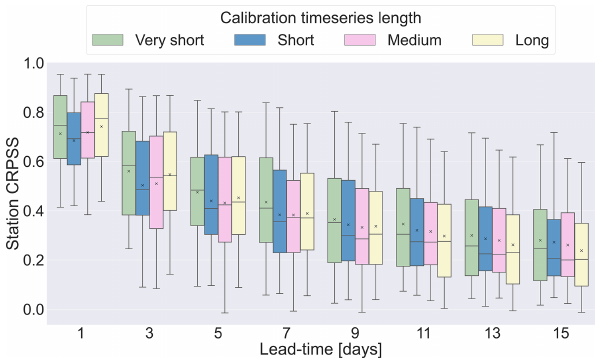
Figure 15. The CRPSS for all 522 stations at every other lead time with stations categorised by the length of their calibration time se- ries. Very short time series: less than 15 years (63 stations). Short time series: 15 to 20 years (93 stations). Medium time series: 20 to 25 years (119 stations). Long time series: over 25 years